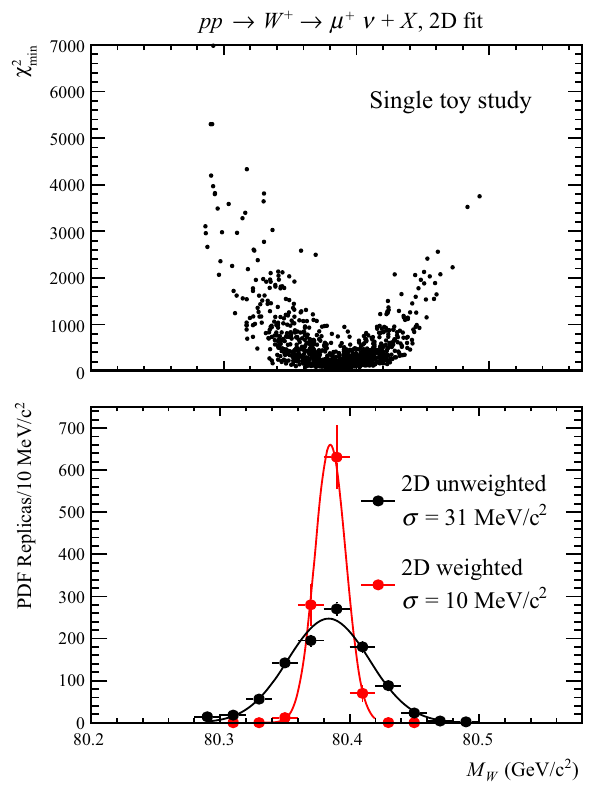
butionoftheextracted M W values,withaGaussianfitfunctionoverlaid, without (black) and with (red) weighting